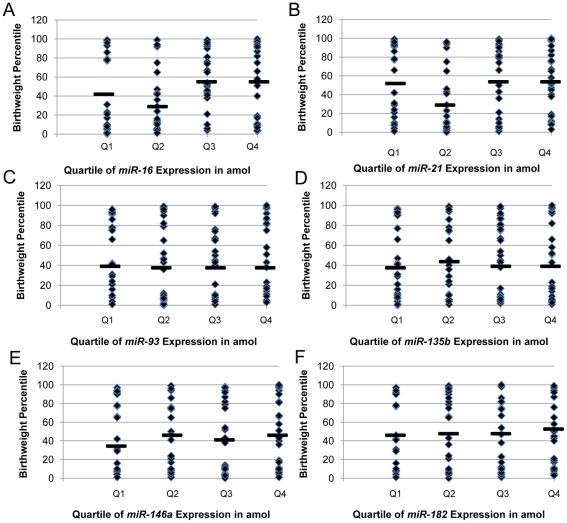
Distribution of infant birthweights (y-axis) by primary term human placenta miRNA expression quartiles (x-axis).(A) miR-16 (p = 0.04), (B) miR-21 (p = 0.02), (C) miR-93 (p = 0.88), (D) miR-135b (p = 0.84), (E) miR-146a (p = 0.46), and (F) miR-182 (p = 0.55). Black bars indicate median of birthweight percentile within each quartile. Kruskal-Wallis tests revealed that birthweight percentile significantly differed across quartiles of miR-16 and miR-21 expression (p<0.05).